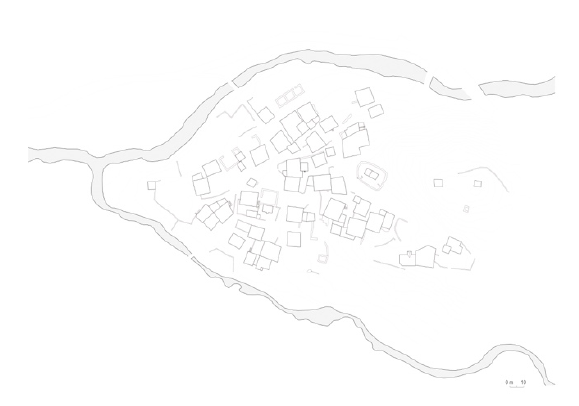
Figure 3. Chazhashi`s, Upper Svaneti, plan, Ci-ESG,